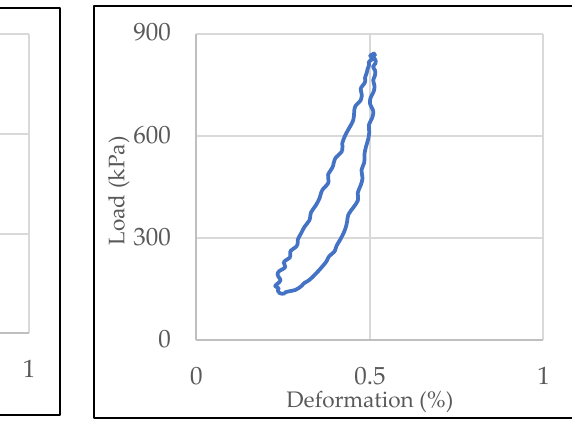
( d ) Figure 8. Elastic hysteresis loops of SMA8 LA (20% RG) mixture with: ( a ) bitumen 50/70, ( b ) modified bitumen 50/70 SBSM-5, ( c ) modified bitumen 50/70 CRM-10, ( d ) modified bitumen 50/70 SBSM-2 + CRM-10. The areas of the elastic hysteresis loops of SMA8 LA and PA8 mixtures at 15 °C, 25 °C and 35 °C are shown in Figure 9.